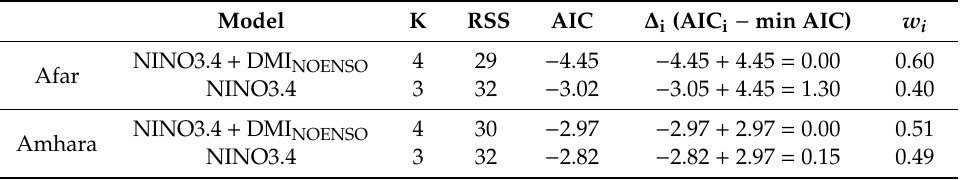
Table 3. Model comparison based on Akaike Information Criterion (AIC) and weights ( w i ) with K number of free parameters. Lower AIC / higher weights indicate preferred models.